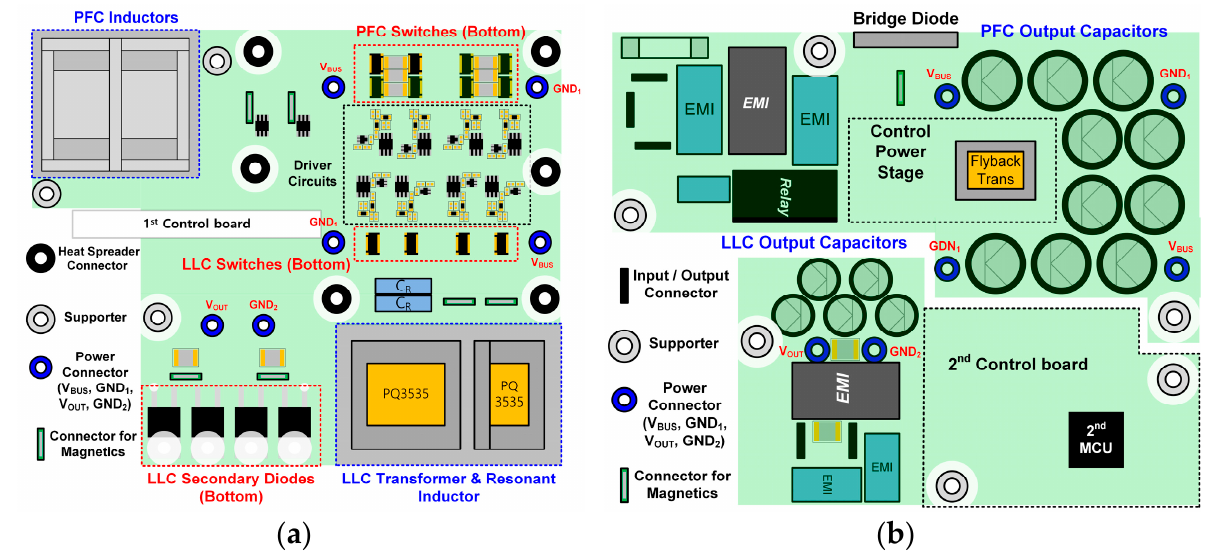
Figure 6. Layout of two PCBs for 3D-PCB design. ( a ) Bottom PCB for lossy components. ( b ) Top PCB for bulky components. The heat spreader is located underneath the bottom PCB to dissipate heat effectively. Table 2. Designed parameters of 3.3 kW full-bridge (FB) LLC resonant converter.